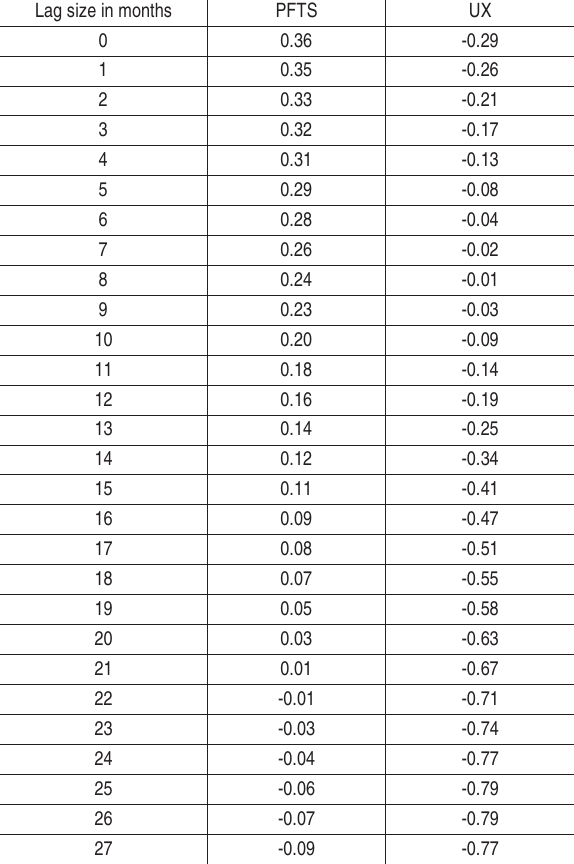
Table 3. The analysis of Ukrainian stock market reactions to the changes of capital base (monthly data)